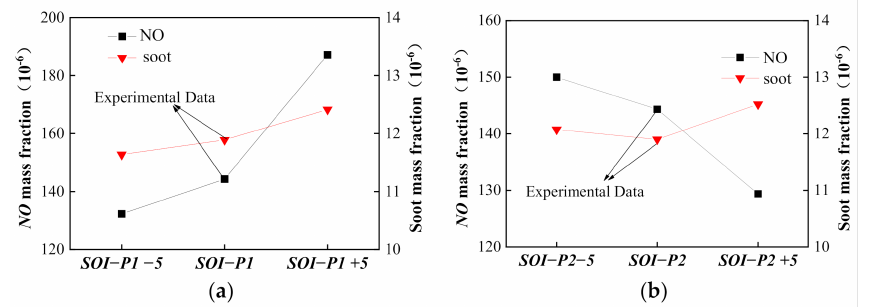
Figure 8. The generation of NO and soot in the cylinder: ( a ) adaptation of SOI − P1 ; ( b ) adaptation of SOI − P2